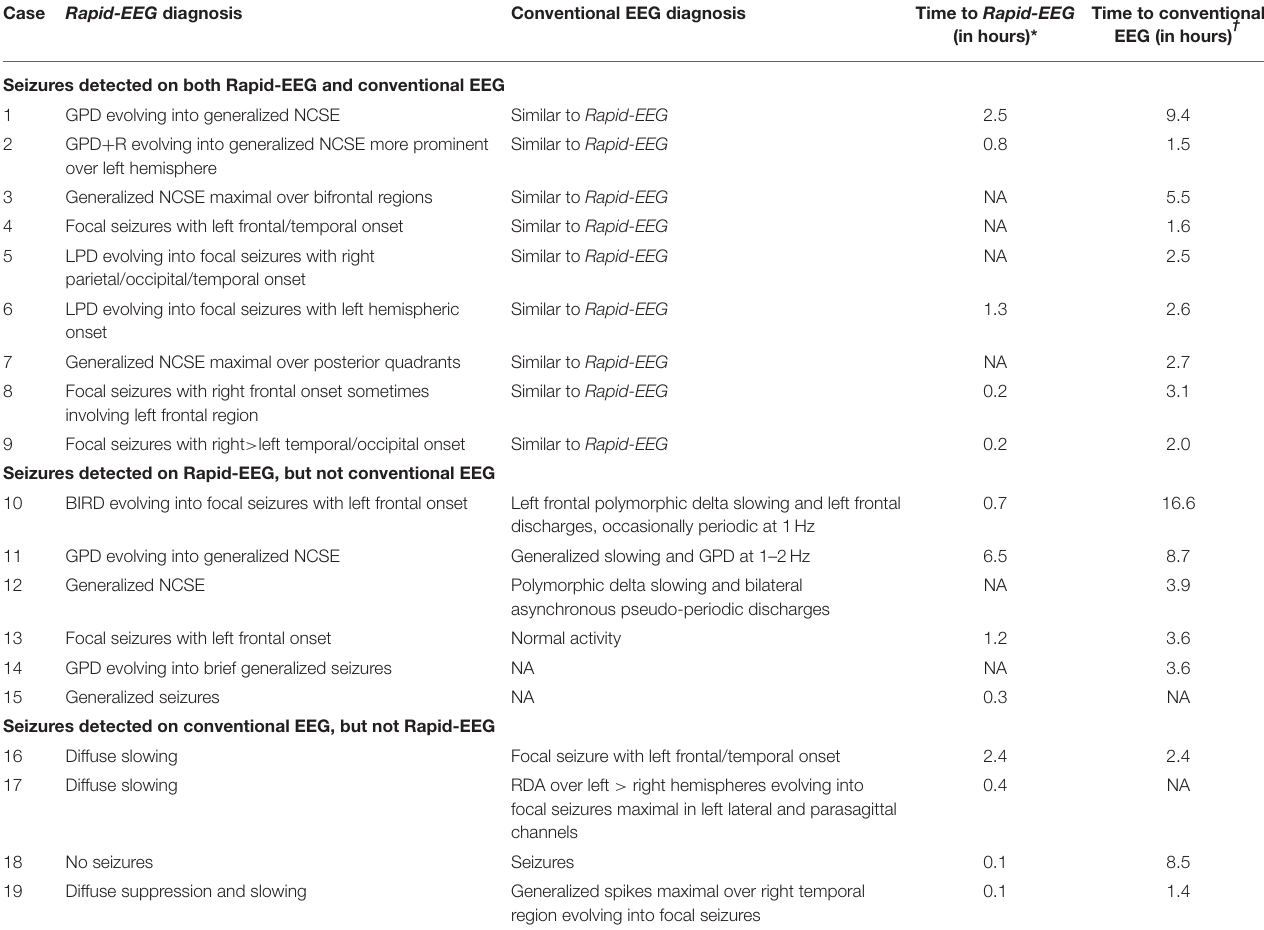
TABLE 1 | Case series